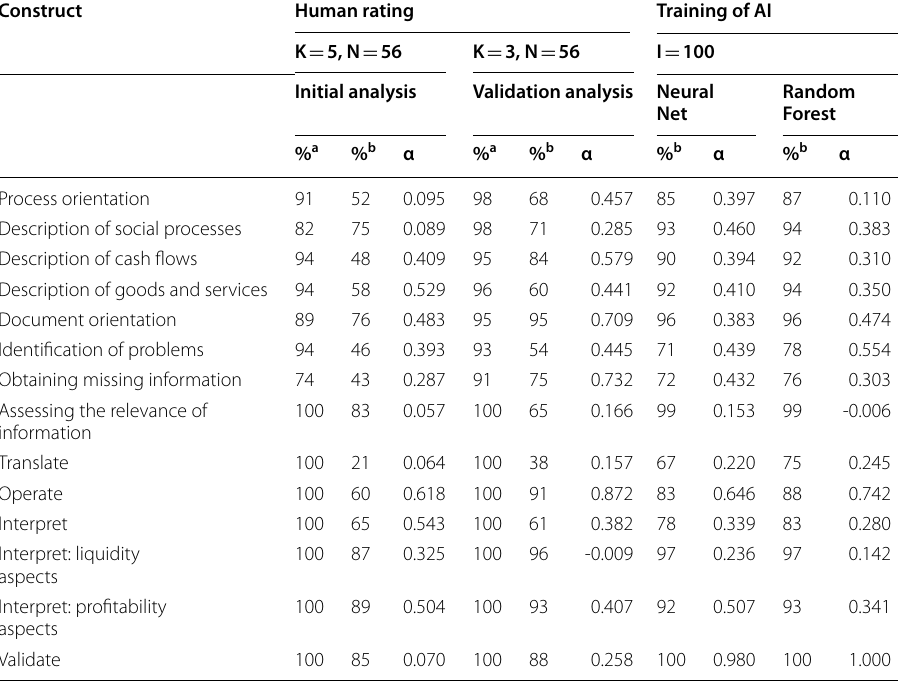
Table 3 Inter-coder reliability measured by Krippendorff’s alpha